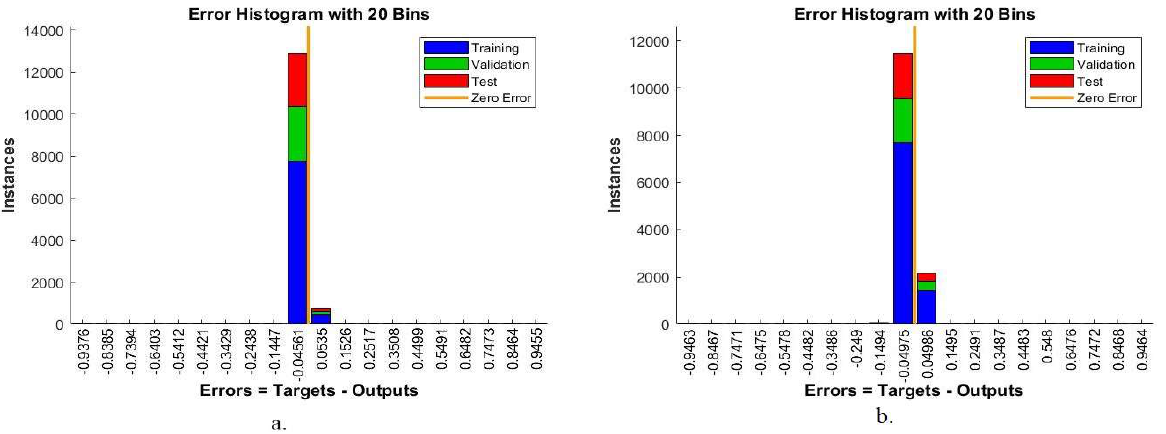
Figure 8. Error histogram for evaluating ANN performance based on hybrid features. ( a ) AlexNet, DWT, LBP, FCH, and GLCM; ( b ) ResNet-18, DWT, LBP, FCH, and GLCM.